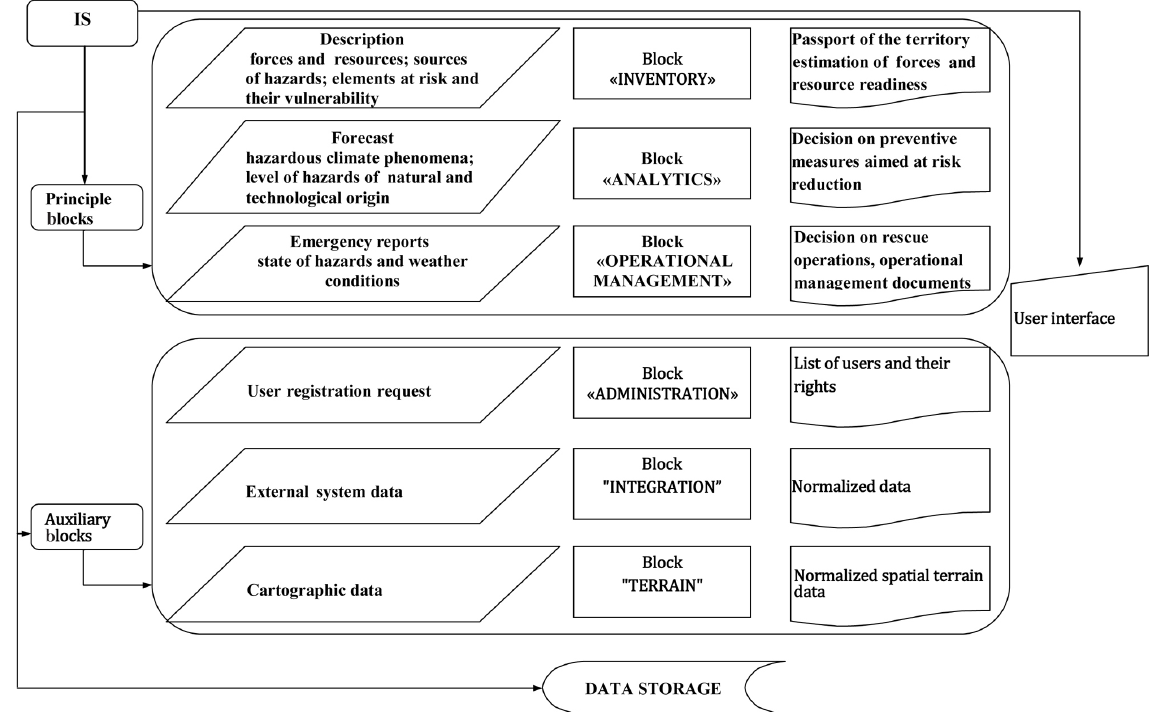
Figure 1. Structure of the EMERCOM information